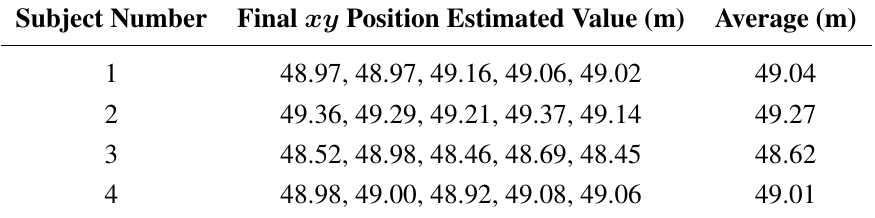
Table 3. Four persons’ 50-m walk experiment